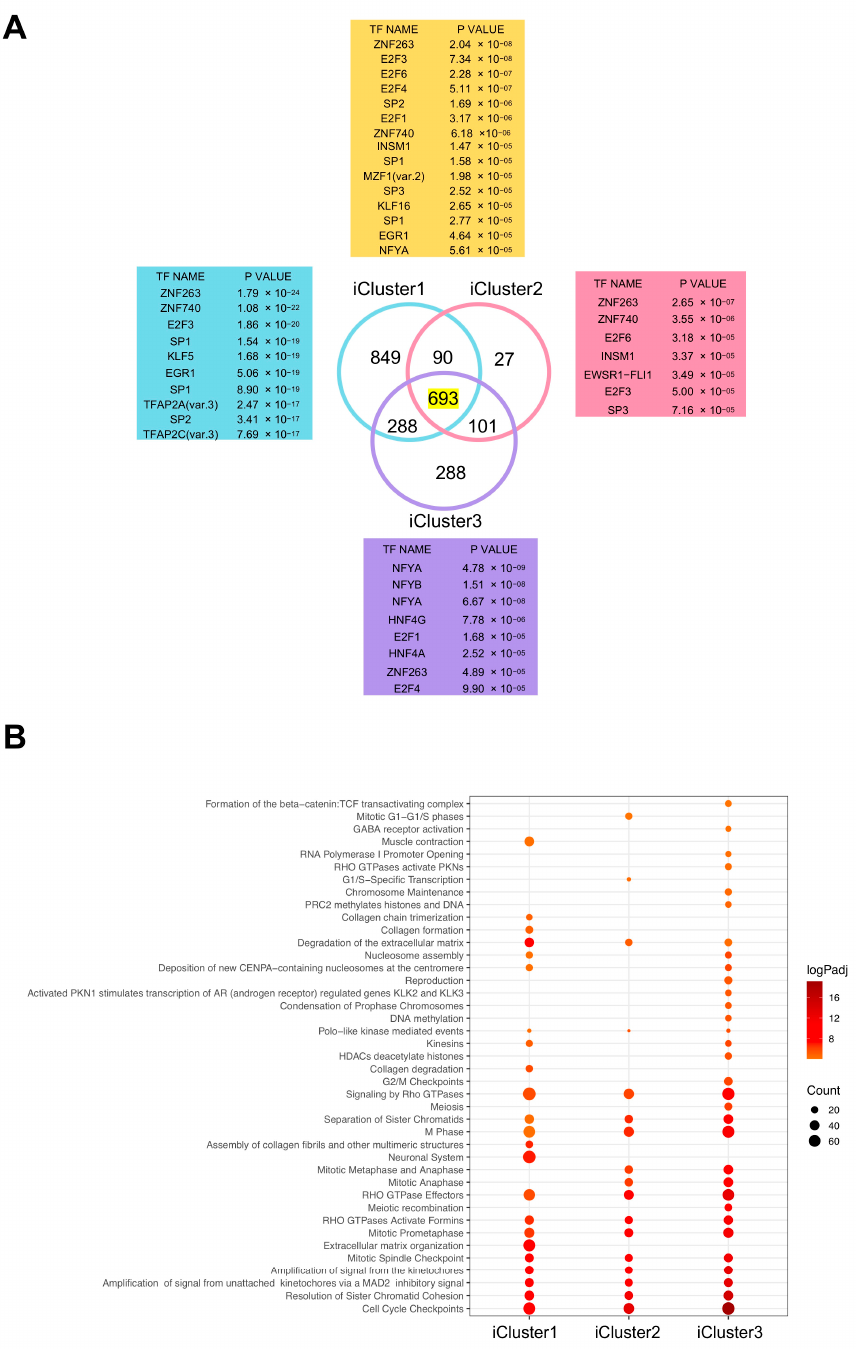
Figure 4. Analysis of HCC iCluster-specific gene expression. ( A ) Venn diagrams of Up-regulated genes in the three di ff erent iClusters and Transcription Factor Binding Sites (TFBS) enriched in their promoters, both in the core set and individually. ( B ) Dotplots of Reactome pathways enriched in upregulated gens of every